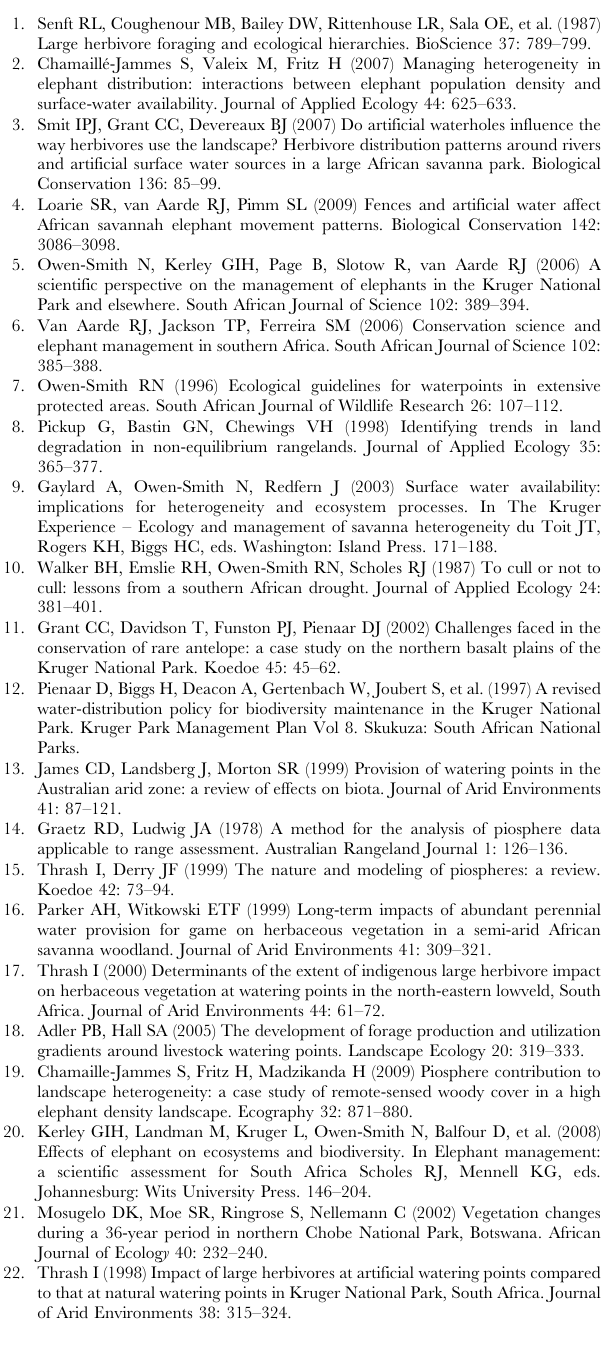
Figure S1 Best-fit mixed-effects logistic growth models of (A) the ratio between areas of run-on and run-off, and (B) the proportion of intact mounds as a function of distance from